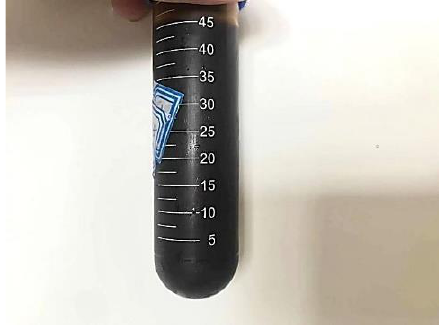
Figure 2. GO solution.